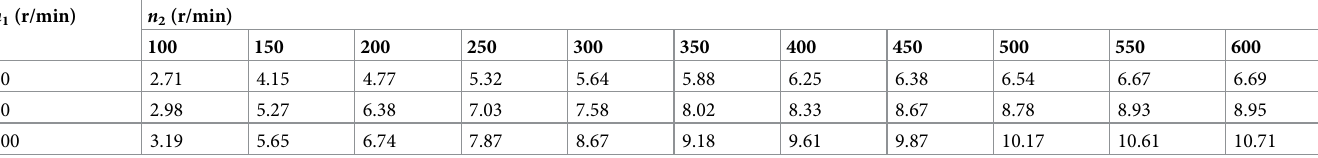
Table 3. Sand productivity of scheme